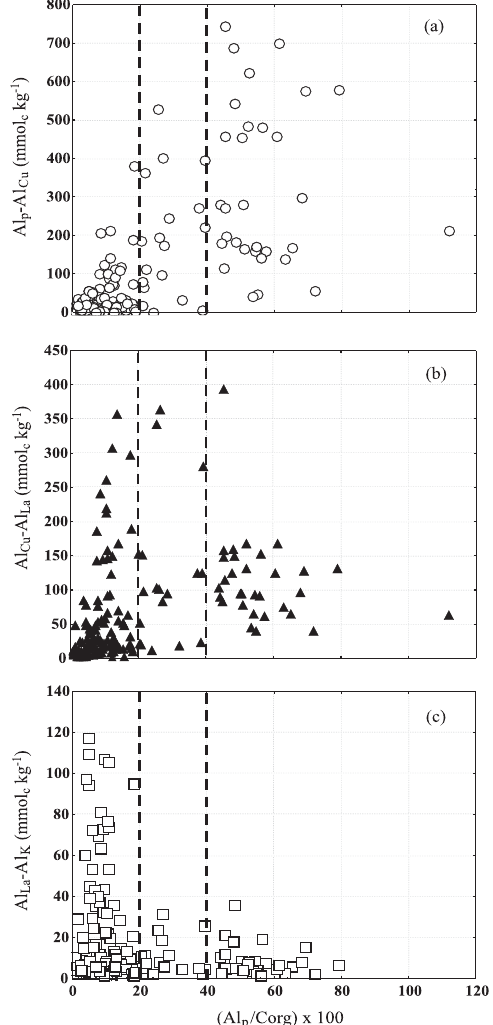
-Al , p Cu -Al ) p Cu